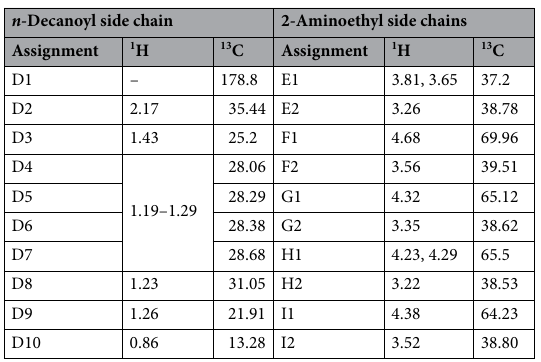
Table 2. NMR assignments for the side chains of compound